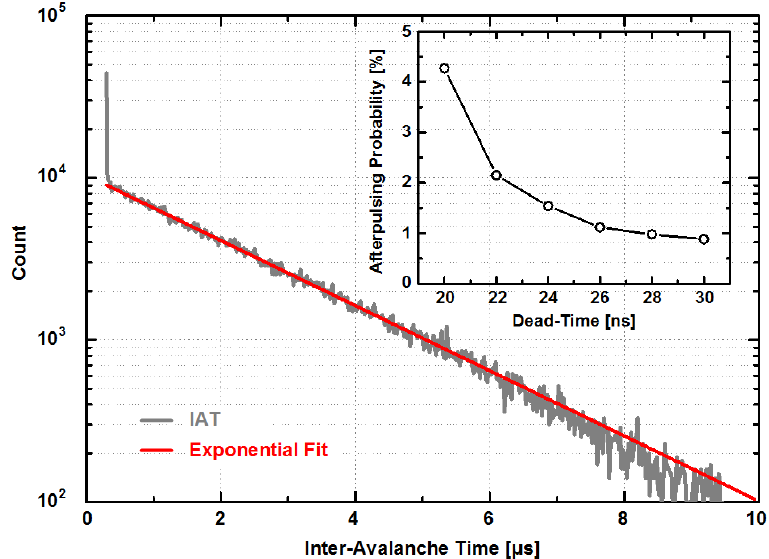
Figure 5. Histogram of inter-avalanche times (IAT) with exponential fit. Inset shows the dead-time dependency of afterpulsing probability.